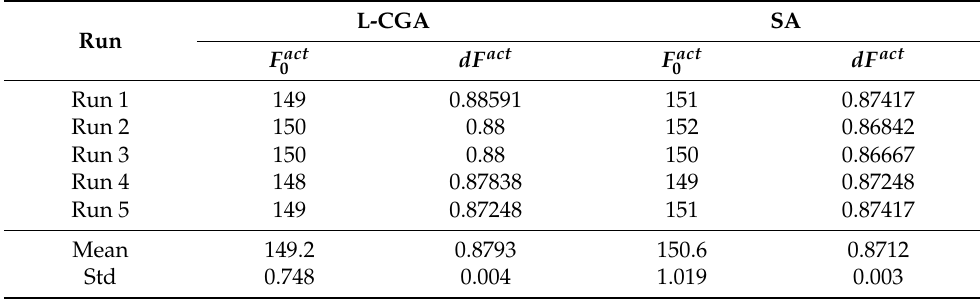
Table 8. Comparison of resonator characteristics achieved by L-CGA and SA, 5 mode